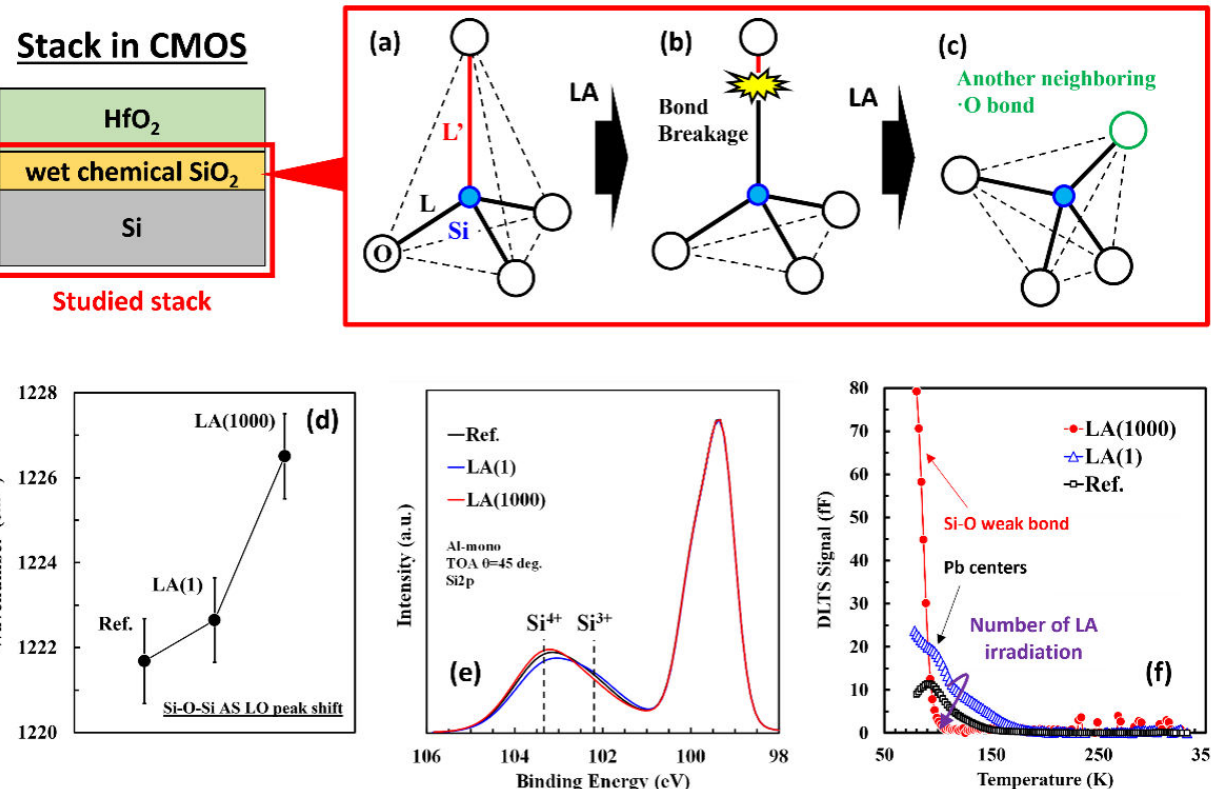
Figure 3. ( a – c ) Schematic figures of a possible local rearrangement procedure of the tetrahedral SiO 4 network. ( d ) Shift of the longitudinal optic (LO) phonon peak of the Si–O–Si asymmetric stretching (AS) vibration as a function of the number of LA irradiation, where LA(1) and LA(1000) stand for 1 and 1000 times irradiation, respectively. ( e ) Normalized Si 2p XPS spectra of the as-grown (Ref.), LA(1), and LA(1000) samples. ( f ) Comparison of the DLTS signals taken for the as-grown (Ref.), LA(1), and LA(1000) samples. Reprinted/adapted with permission from Ref. [23]. 2020, The Japan Society of Applied